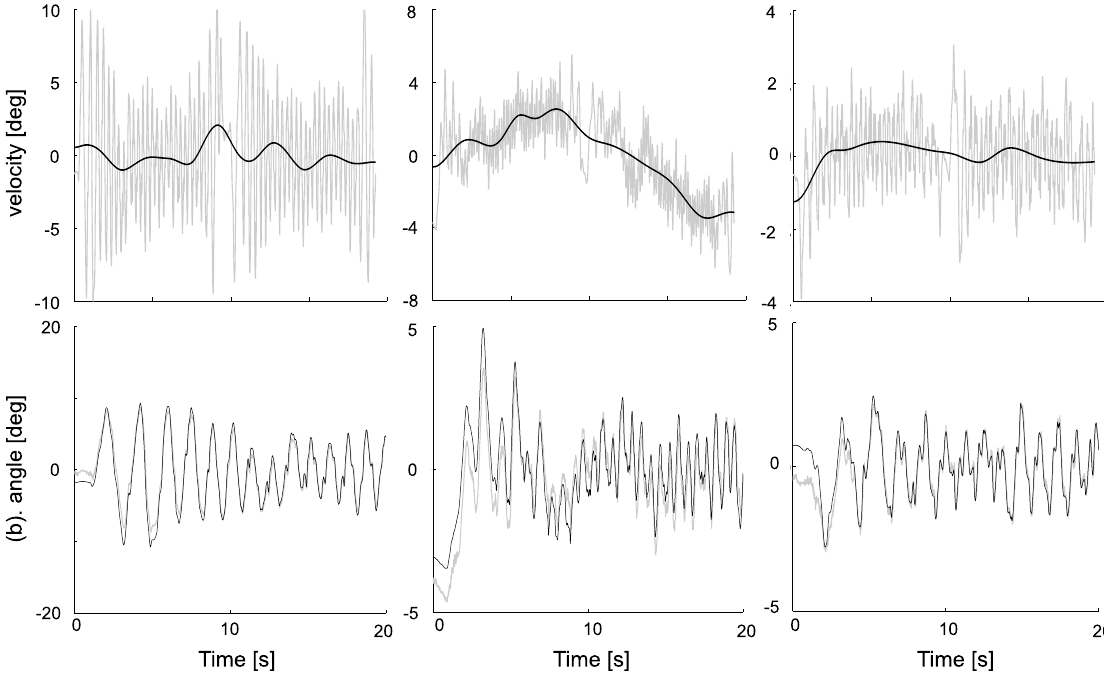
Figure 2. Data relative to the pitch, roll and yaw angles obtained for one randomly selected treadmill walking trial. The integrated angular velocities (grey line) and the resulting trends (black line) are estimated using EMD ( a ) during all the trial; zoom over 20 s on the corresponding detrended angles are thereafter estimated (black line) and compared with those obtained using stereophotogrammetry (grey line) ( b